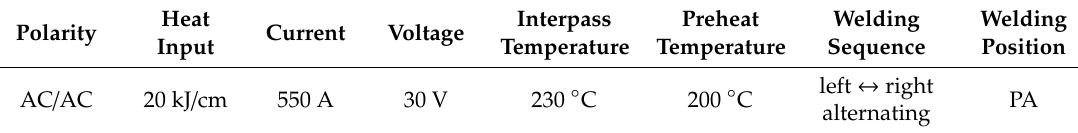
Table 1. Overview of the Tandem-SAW (submerged-arc welding) conditions.